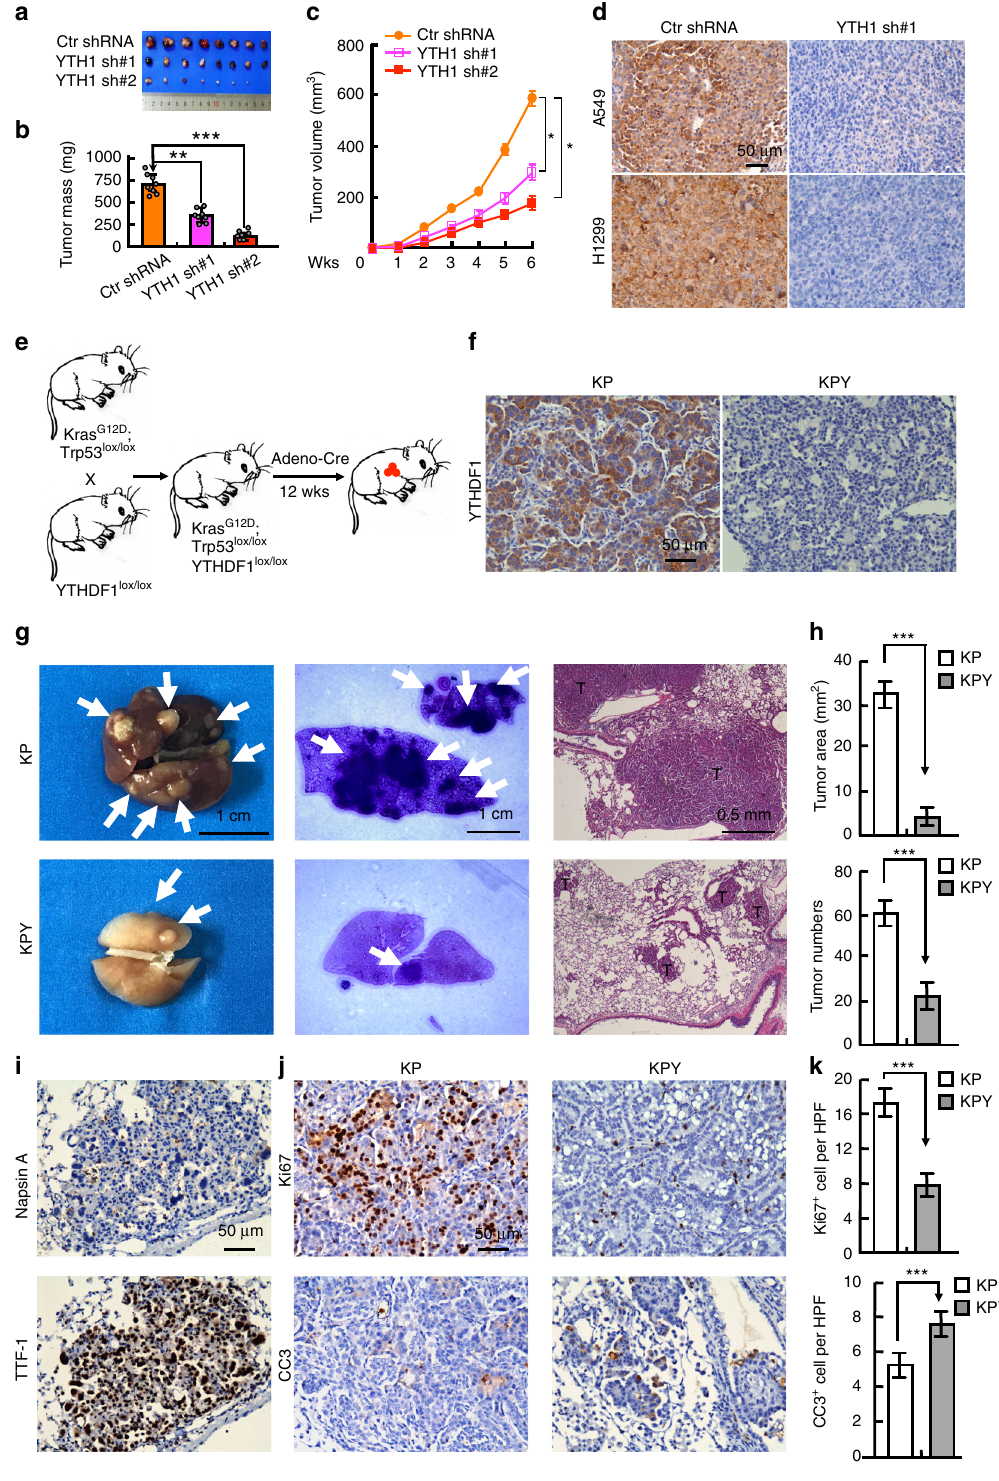
Fig. 3 YTHDF1 depletion inhibits de novo ADC progression. a Xenograft tumor masses harvested from indicated A549 cell lines after tumors had grown for 42 days. b , c YTHDF1 elimination inhibits xenograft tumor weight ( b ) and volumes ( c ) in male nude mice. d Representative IHC images showing YTHDF1 knockdown in xenografts. Scale bar: 50 μ m. e A scheme of Adeno-Cre treatment-induced KP and KPY mouse models. f YTHDF1 is upregulated in ADC from KP mice compared with the complete loss of YTHDF1 in KPY mouse tumors. Scale bar, 50 μ m. g , h Representative images of H&E-stained lung sections of KP or KPY mice at 12 weeks after viral administration ( g ). Quanti fi cation data for the tumor numbers and tumor size ( ≥ 1 mm 2 ) in KP or KPY mice ( h ). Scale bars are indicated in each image. T Tumor tissues. i Representative images of positive staining of Napsin A and TTF-1 for KP mice ADC tumors. Scale bar, 50 μ m. j , k Representative images of Ki67 and CC3 immunostaining ( j ) of lung tumors and statistical analyses of the Ki67- and CC3- positive index in the indicated genotype ( k ), respectively. CC3: cleaved caspase 3. Scale bar, 50 μ m. Means ± SEM, * P < 0.05; t